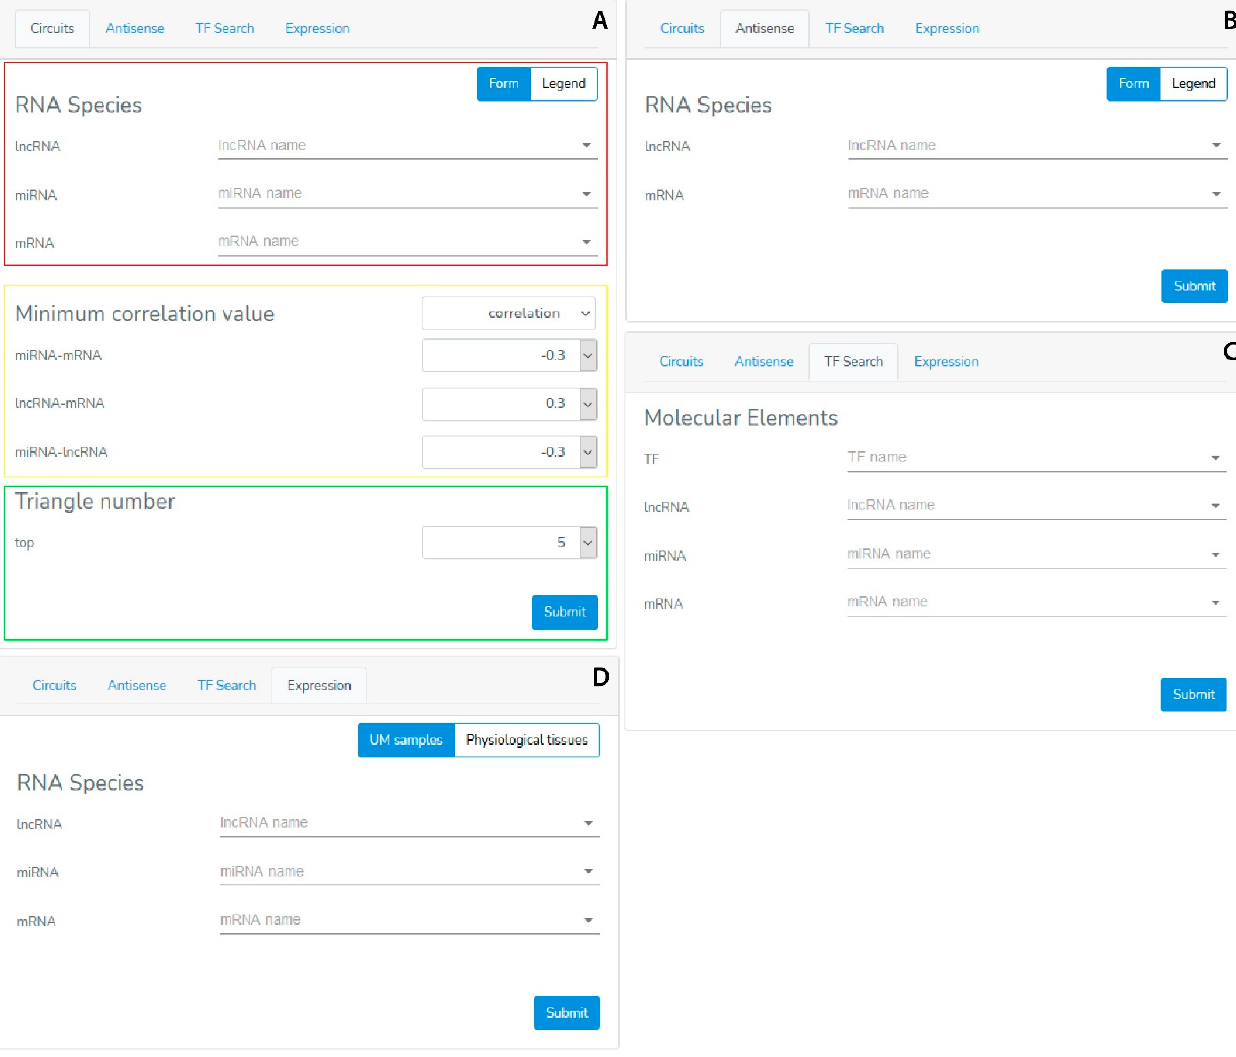
Figure 2. Menu section of the VECTOR database. ( A ) The “Circuit” menu queries the database by choosing at least an RNA molecule (lncRNA and/or miRNA and/or mRNA), a minimum correlation value for each pair and the number of network motifs to be shown. Alternatively, user can filter the output by p -value. ( B ) The “Antisense” menu identifies sense-antisense pairs by choosing a lncRNA and/or mRNA. ( C ) The “TF Search” menu retrieves information on potential TFs regulating lncRNA, miRNA or mRNA expression in UM by choosing a TF and/or a lncRNA, a miRNA, or a mRNA. ( D ) The “Expression” menu allows to inspect the expression of a chosen lncRNA, miRNA or mRNA in UM samples or several physiological tissues.